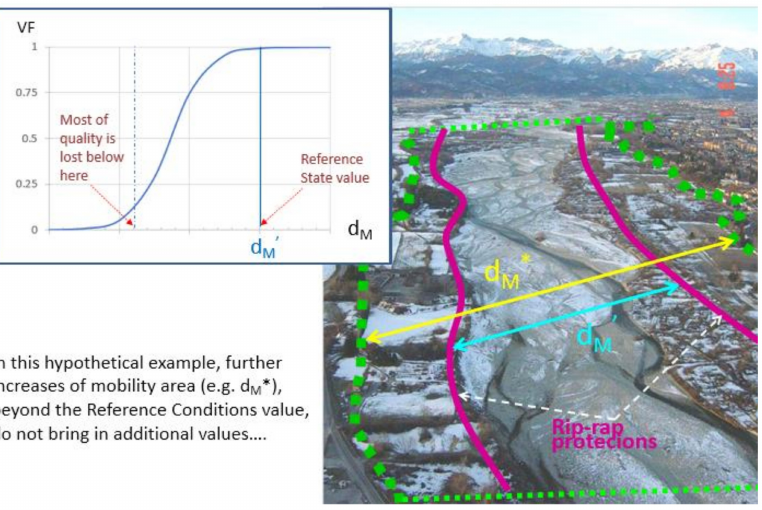
Figure 8. Example of a sub-index that assesses the mobility space (its “width”). The indicator on the horizontal axis is the area of the mobility strip. The reference value d M ’ appears explicitly as a structural element of the scalar Value Function (VF) and corresponds to the adopted Reference Status (or, better, to its specific River Styles). Photo: PPT “Il fiume in Piena”, Comune di Cuneo, Piemonte Italy (2004), with